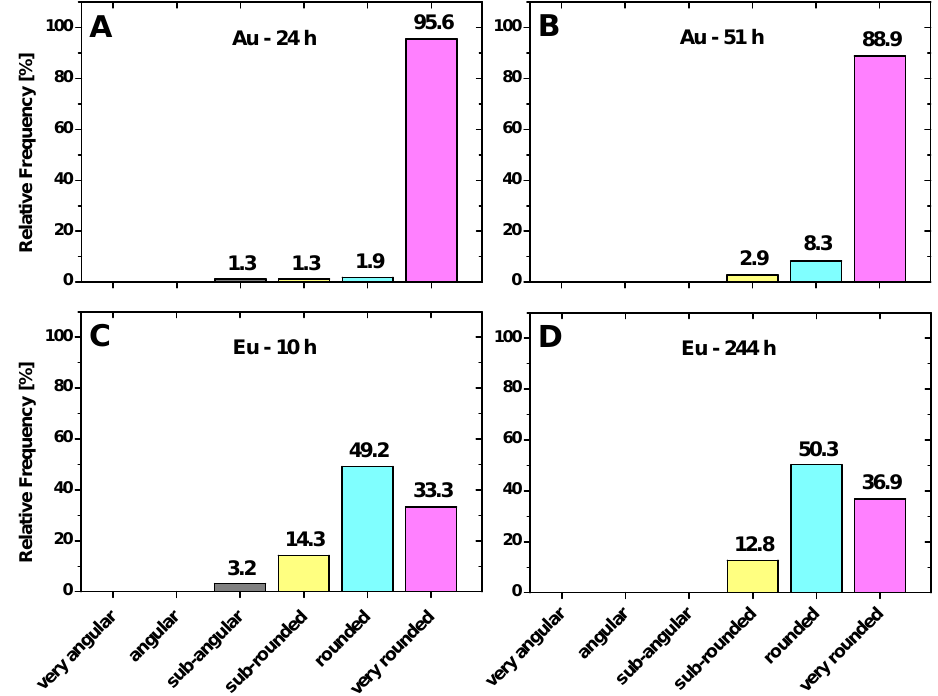
Figure 6. Shape classification into six different classes for Au-NPs after 24 h ( A ) and 51 h ( B ) growth time and for Eu-NPs after 10 h ( C ) and 244 h ( D ) with the indication of percentages. In this biorecovery process, metal ions are adsorbed via the cell surface and